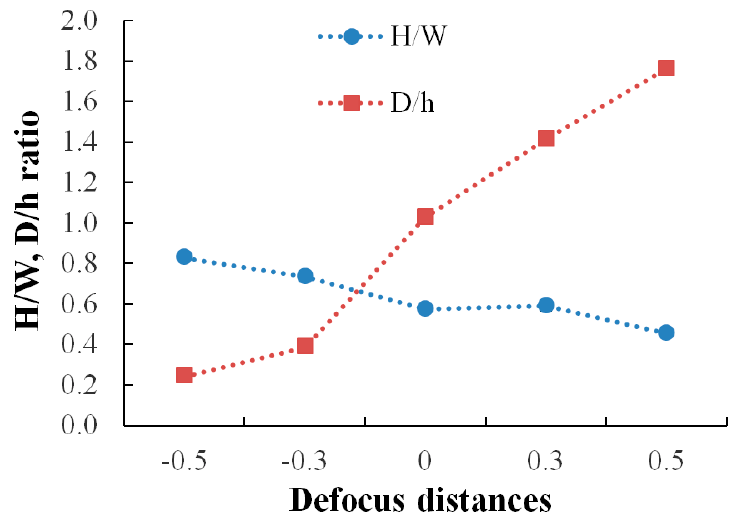
Figure 5. Influence of defocusing on melt pools height/width and depth/height ratio.